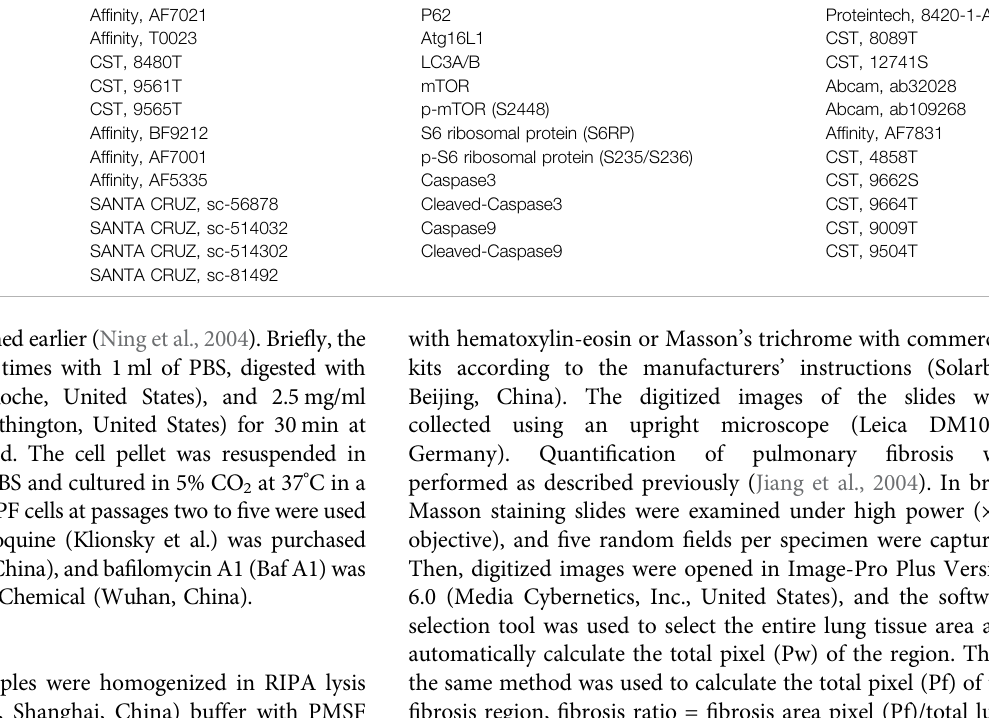
TABLE 1 | The list of primary antibodies. Antibody Company and Item